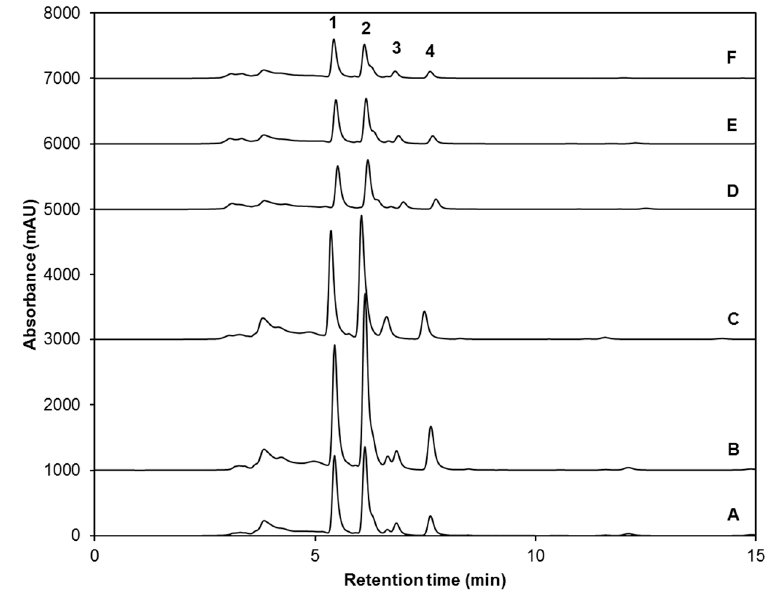
Figure 3. HPLC-DAD chromatograms (shown at 450 nm) of identified carotenoids and chlorophylls from ethanol/water (70:30, v/v ) extracts of: ( A ) untreated control eight-day-old broccoli sprouts, broccoli sprouts treated with ( B ) UVA or ( C ) UVB radiation at the 7th day after sowing and harvested 24 h after the UV treatment; ( D ) eight-day-old broccoli sprouts treated with methyl jasmonate (25 µ M) every 12 h from sowing until harvest, and broccoli sprouts treated with both methyl jasmonate (25 µ M, every 12 h for eight days) and ( E ) UVA or ( F ) UVB radiation at the 7th day after sowing and harvested 24 h after the UV treatment. Peak assignment is shown in Table 5. Lutein (1); Chlorophyll b (2); Neoxanthin (3); Chlorophyll a (4).